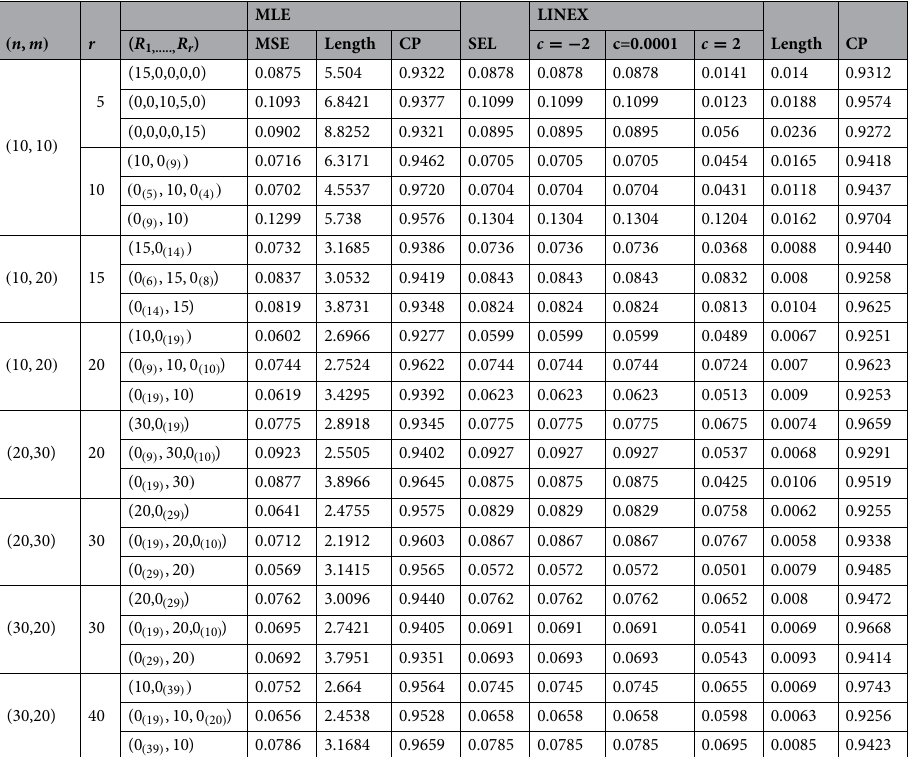
Table 8. MSE, length and coverage probability (CP) of estimates for the parameter β 2